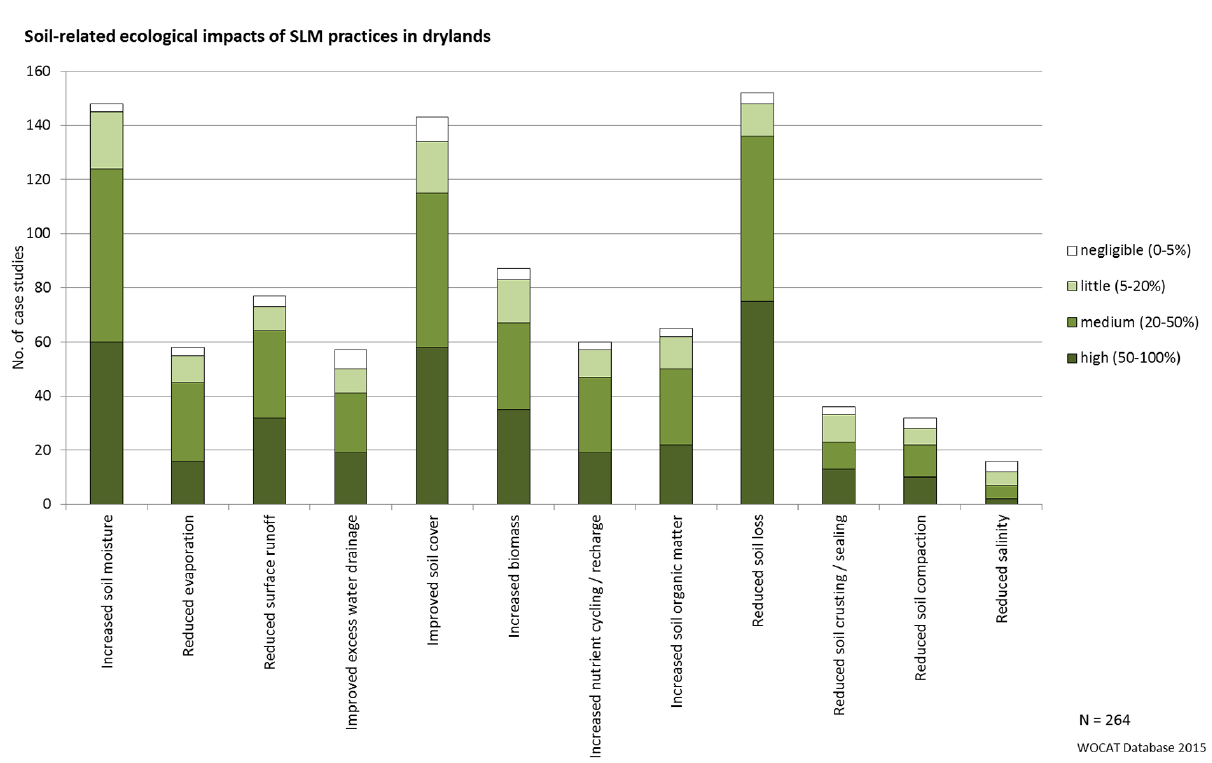
Figure 3. Soil-related ecological impacts of SLM practices in drylands (source: WOCAT, 2015).